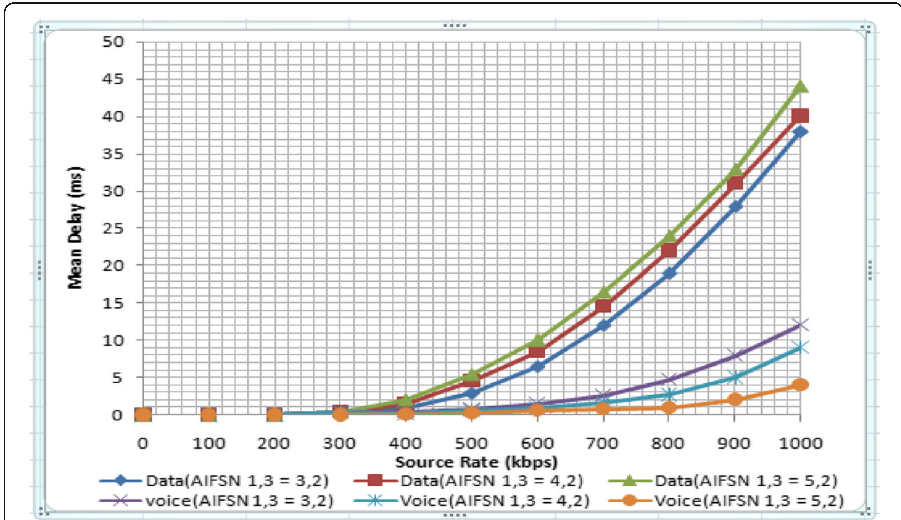
Fig. 14 Average delay of BE and VO traffic at varied AIFSN versus source